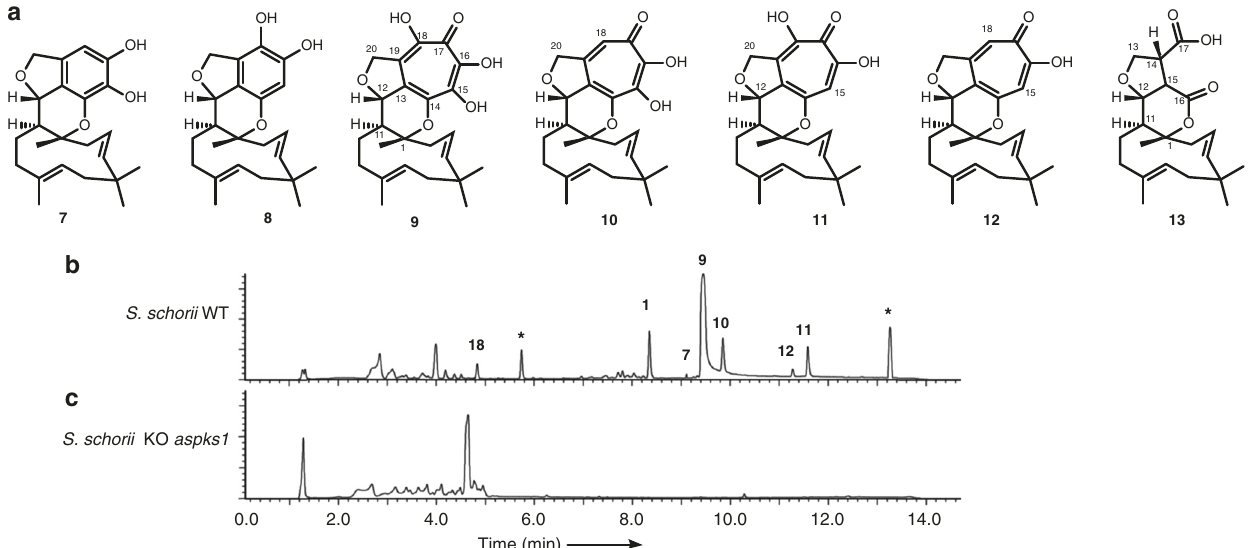
Fig. 2 Isolation of wild-type compounds. a Compounds isolated from S. schorii ; b HPLC (diode array detector) trace of organic extracts from WT S. schorii , * = unrelated compound and c HPLC (diode array detector) trace of organic extracts from S. schorii Δ